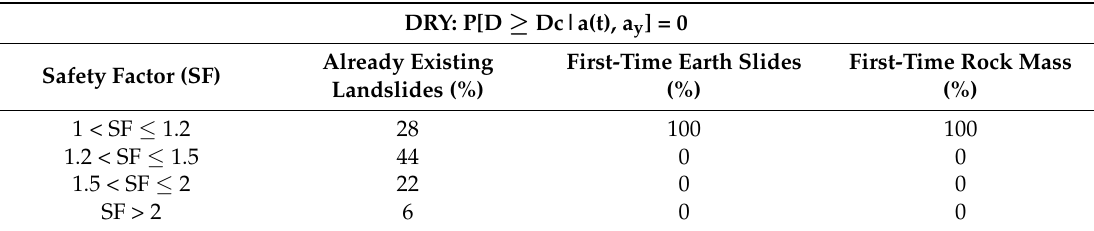
Table 3. Safety factor values computed in the dry scenario for different landslide typologies.